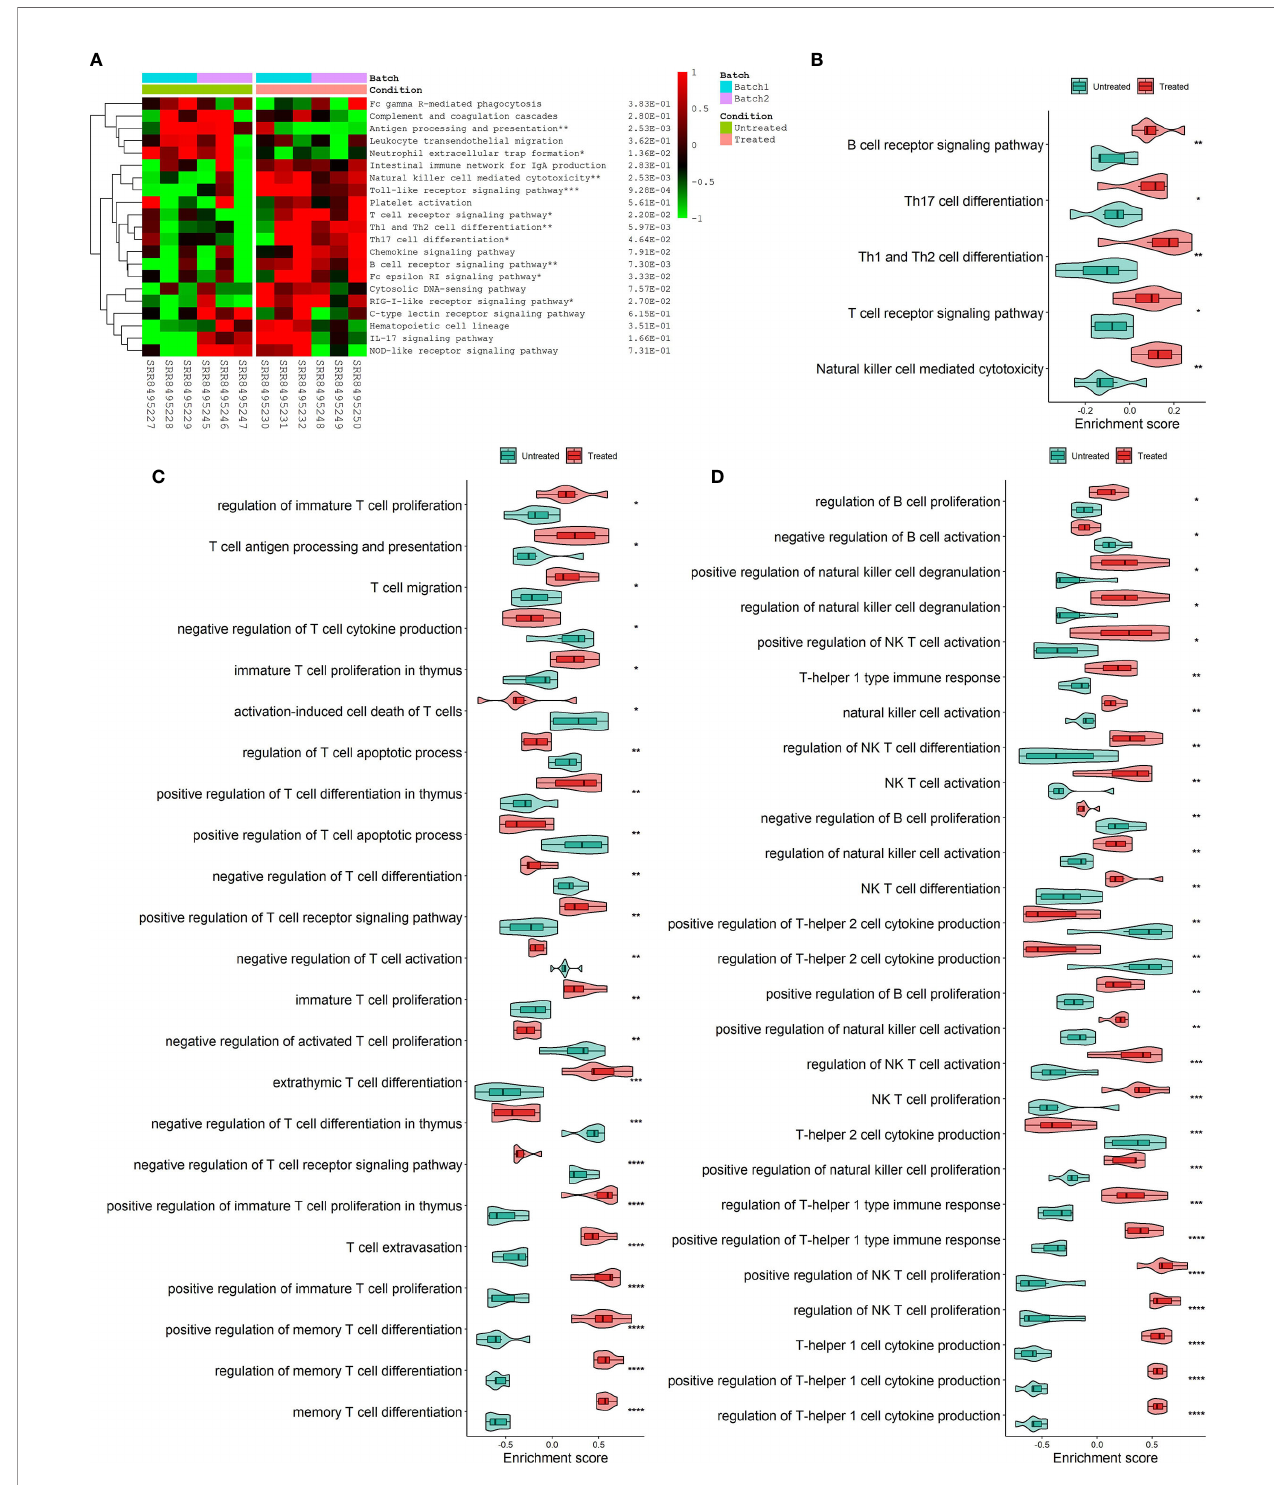
FIGURE 4 | Differences in immune-related process activities scored per sample by GSVA between CKI-treated and control groups. (A) Clustering results of KEGG immune system pathway activities between CKI-treated and control groups. (B) Main differential KEGG immune system pathways activated in the CKI-treated group ( P < 0.05). (C) Signi fi cantly different GO biological processes (adjusted P < 0.05) correlated with T cells between CKI-treated and control groups. (D) Signi fi cantly different GO biological processes (adjusted P < 0.05) correlated with Th1, Th2, B, NK and NK T cells between CKI-treated and control groups (*0.01 < P < 0.05; **0.001 < P < 0.01; ***0.0001 < P < 0.001; **** P <